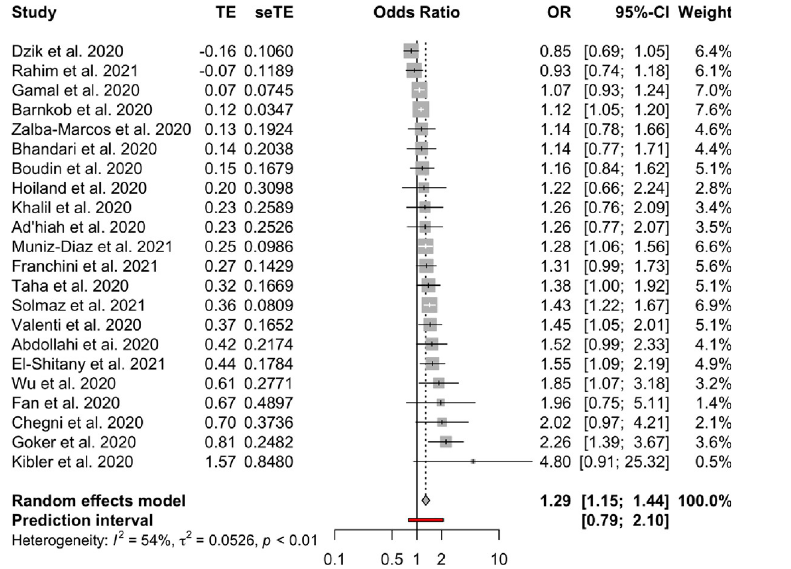
Fig 4. Forest plots for the ABO gene comparison of A vs. O group.